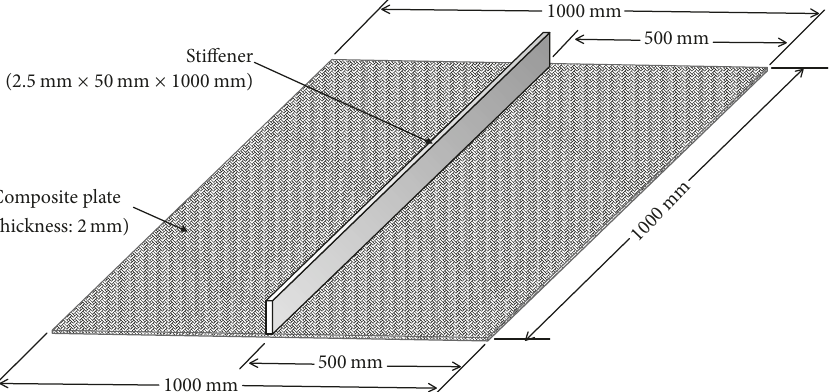
Figure 3: Stiffened composited plate.